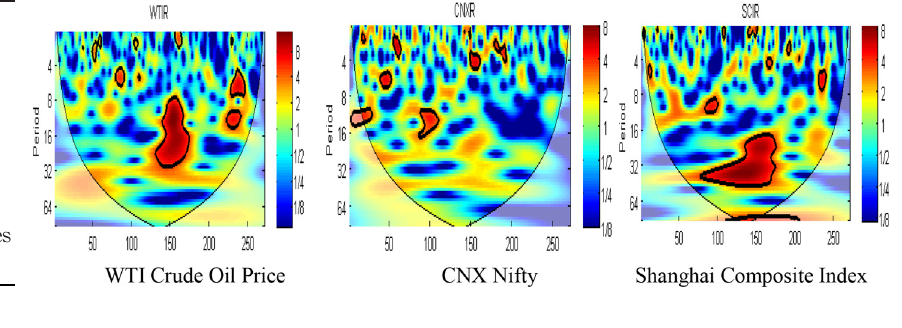
Figure 6. Wavelet power spectrum of variables under